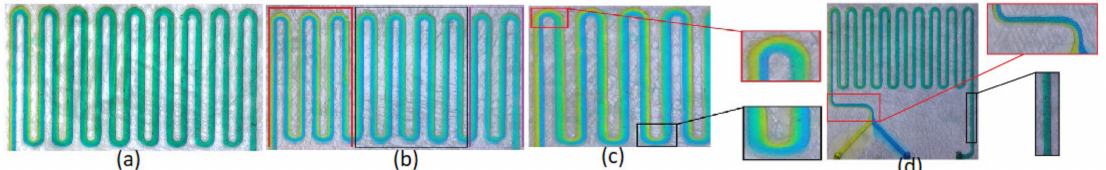
Figure 7. Mixing obtained in SLA micro-mixer. ( a ) flow rate of 10 µ L / min; ( b ) flow rate of 50 µ L / min;